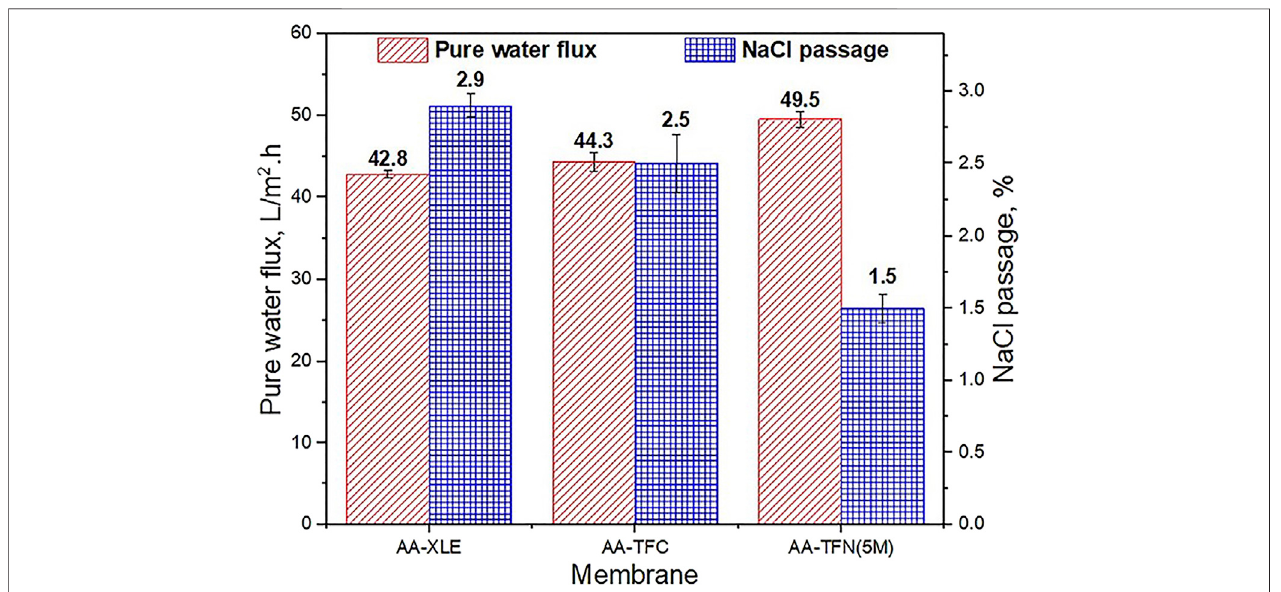
FIGURE 9 | Pure water fl ux and NaCl permeability without and with acrylic acid (AA) monomer on the PA surface of TFN membrane (Siew Khoo et al., 2021).